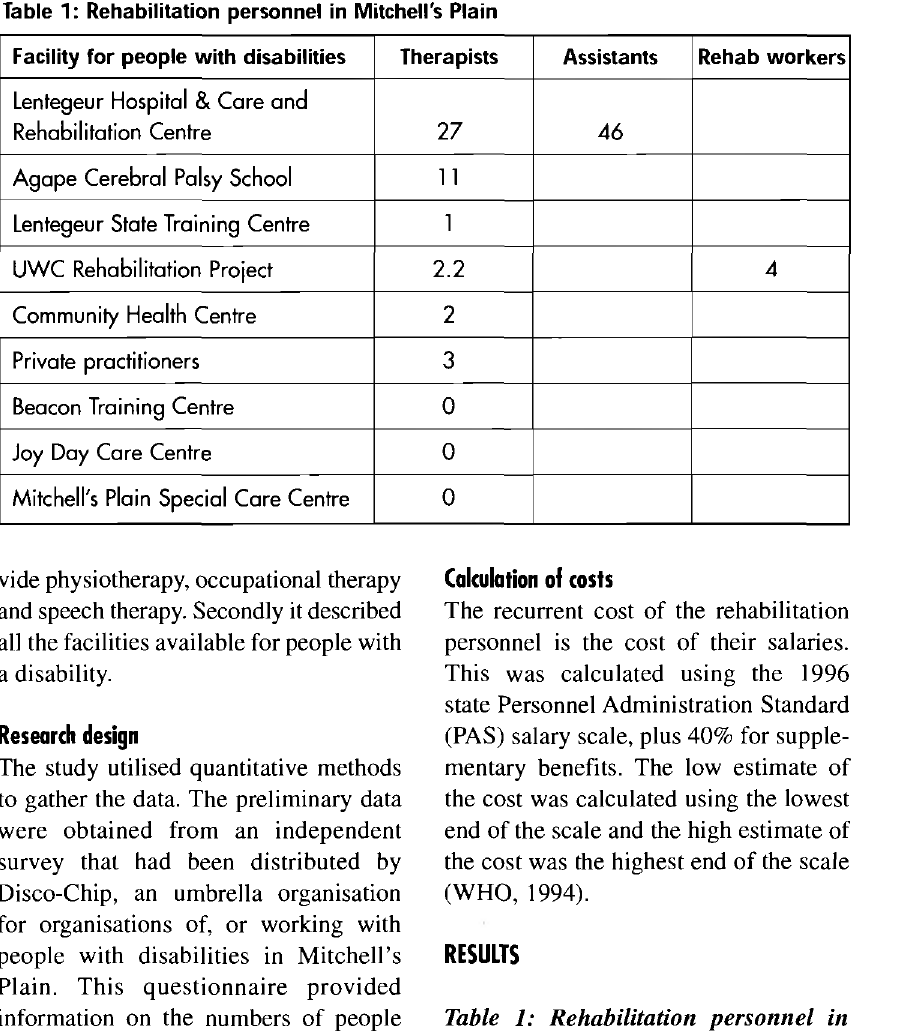
Table 1: Rehabilitation personnel